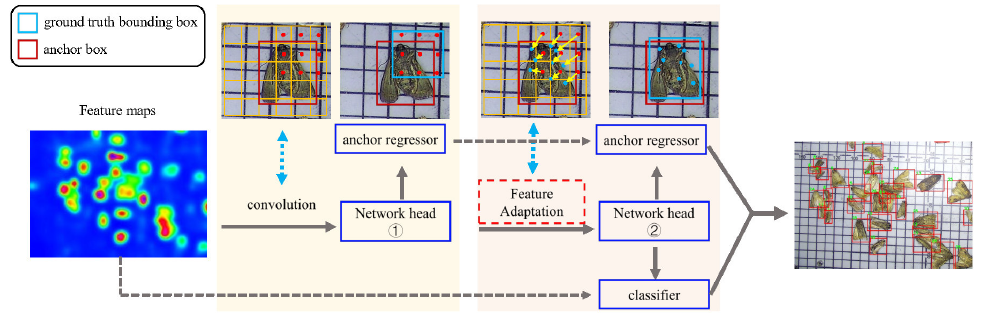
Figure 6. Illustration of